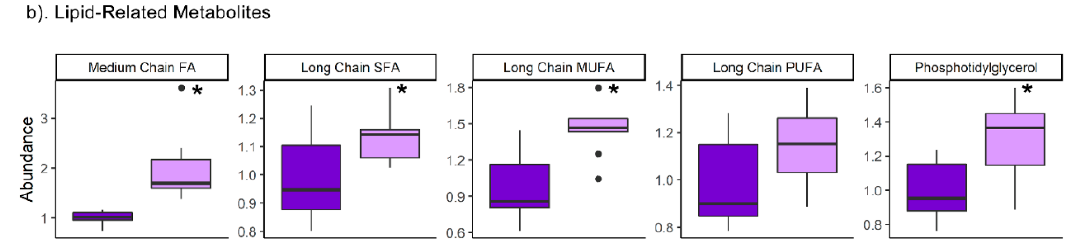
Figure 3. Relative abundance of ( a ) glucose and TCA cycle intermediates and ( b ) lipid classes in ALC vs. CON in maternal liver. Lipid classes are: medium chain FAs (C6:0–C12:0), saturated FAs (C14:0–C22:0), monounsaturated FAs (C14:1–C22:1), polyunsaturated FAs (C14:2–C24:6), in CON is normalized to 1.0, and comparisons used Wilcoxon test. Boxplots depict the data’s spread (measured in inter quartile range), middle line depicts the median, and the dots indicate outliers. * q ≤ 0.05, # 0.05 < q ≤ 0.10. Alpha-KG—alpha-ketoglutarate; FA—Fatty Acid; Fructose-